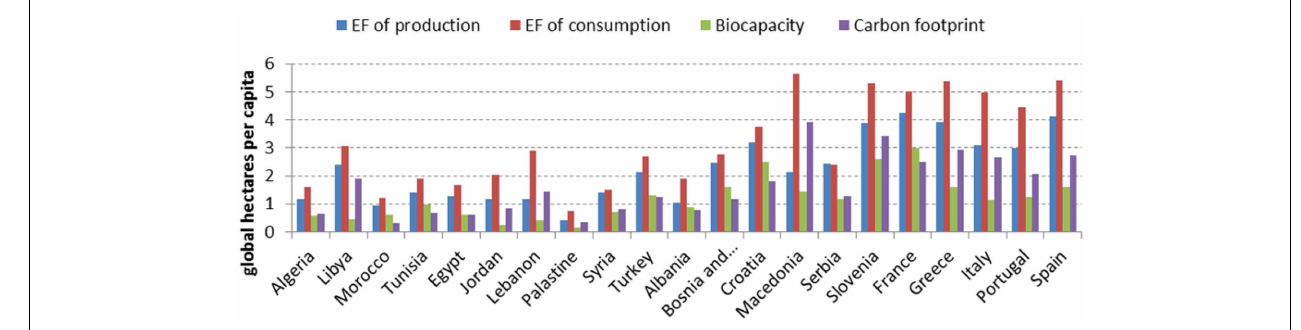
FIGURE 1 | EF of production, EF of consumption, Biocapacity , and Carbon footprint in the Mediterranean region [Source: adapted from Ref. (42)] .